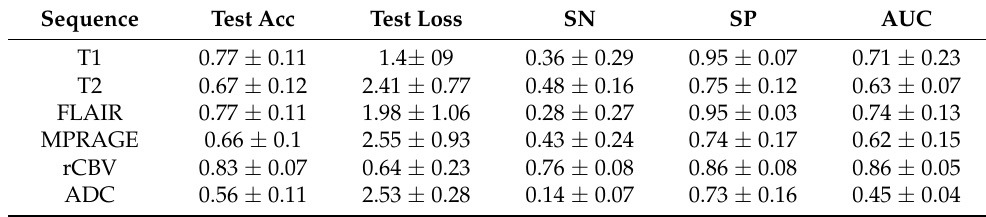
Table 2. Predictive performance of each MR sequence indicated as mean ± standard